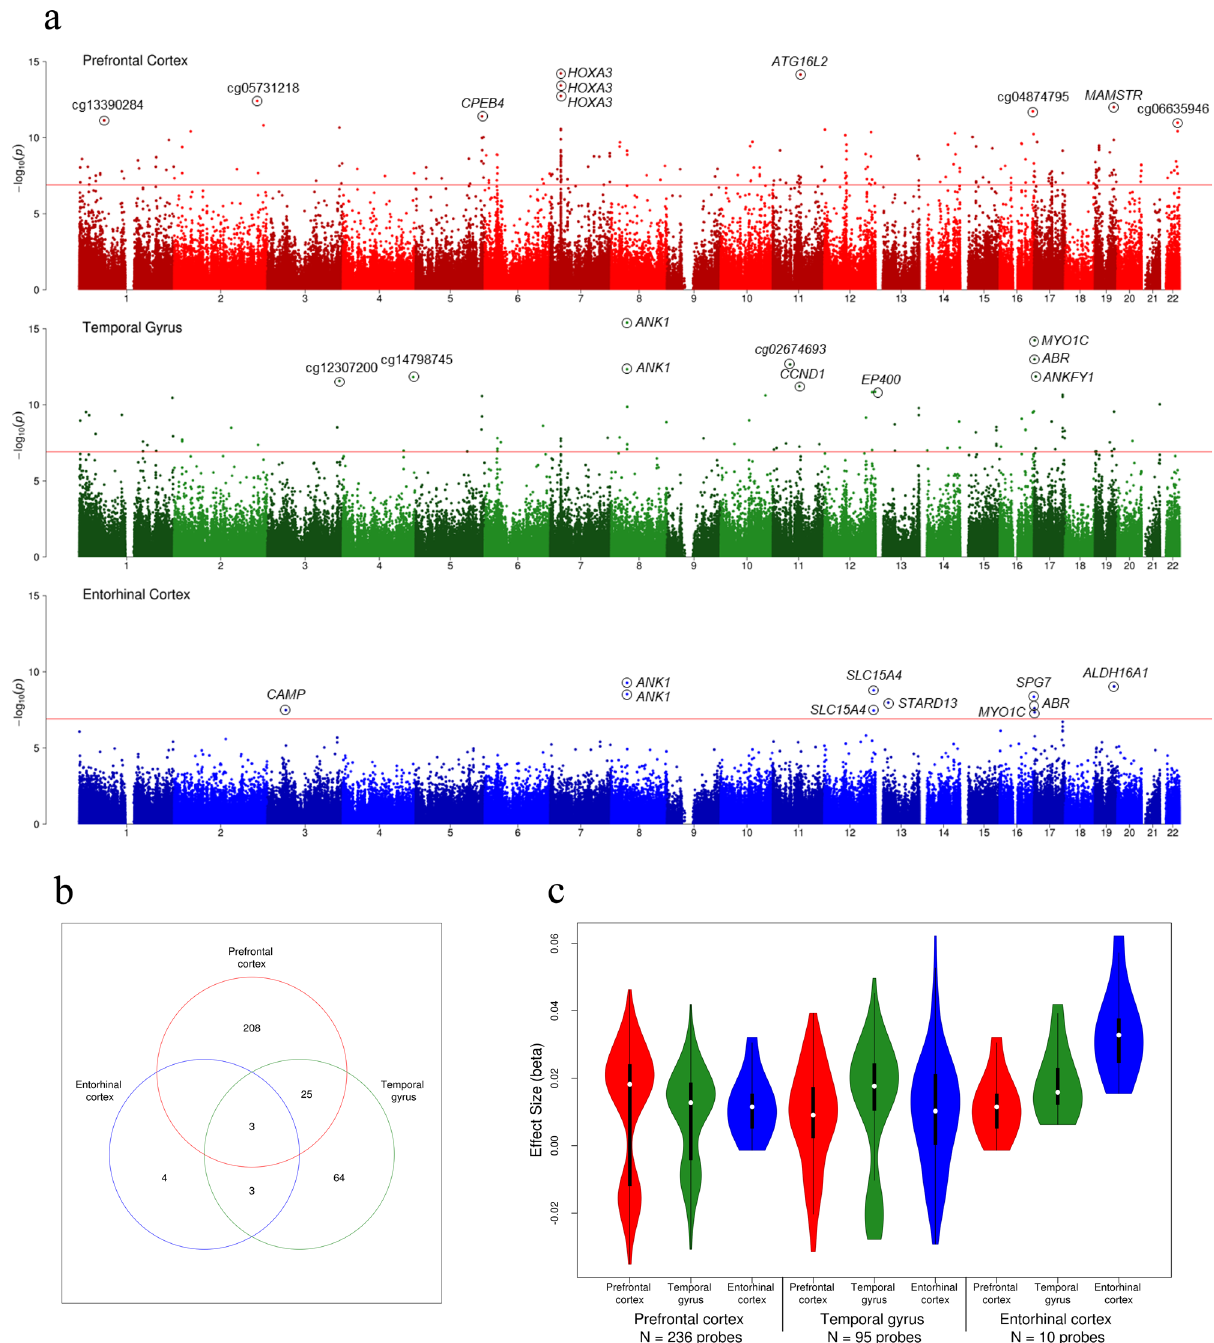
Fig. 1 Intra-tissue meta-analyses of AD methylomic studies highlights Bonferroni signi fi cant differentially methylated positions (DMPs) in all cortical tissues. a A Manhattan plot for the prefrontal cortex (red, N = 961), temporal gyrus (green, N = 608) and entorhinal cortex (blue, N = 189) meta-analyses, with the ten most signi fi cant DMPs circled on the plot and Illumina UCSC gene name shown if annotated, or CpG ID if unannotated. The X -axis shows chromosomes 1 – 22 and the Y -axis shows − log10( p ), with the horizontal red line denoting Bonferroni signi fi cance ( P < 1.238 × 10 − 7 ). b A Venn diagram highlighting overlapping DMPs at Bonferroni signi fi cance across the cortical tissues. c In each cortical brain region the Bonferroni signi fi cant DMPs identi fi ed in that region usually had a greater effect size (ES) there, than in any of the other cortical regions. The X -axis represents the methylation (beta) ES between individuals that are Braak stage 0 and VI. Data are separated on the Y -axis by tissue analysis (large text) with the corresponding data at these probes in other tissues (small text). The white dot in the centre represents the median, the dark box represents the interquartile range (IQR), whilst the whisker lines represent the “ minimum ” (quartile 1 – 1.5 × IQR) and the ‘ maximum ’ (quartile 3 + 1.5 × IQR). The coloured violin represents all samples including outliers, meaning that the ‘ minimum ’ and ‘ maximum ’ may not extend to the end of the